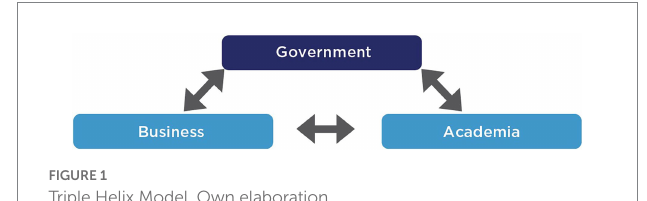
FIGURE 1 Triple Helix Model. Own